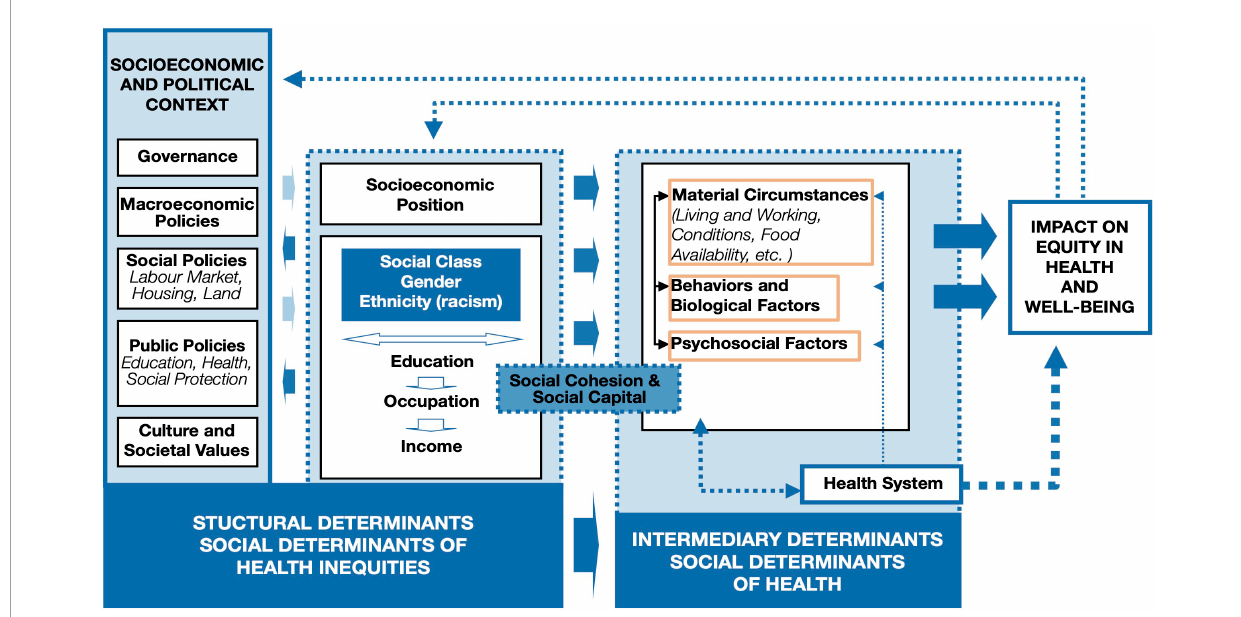
FIGURE1 The World Health Organization (WHO) social determinants of health framework structural factors, deeply rooted in imperial policies, influence individual-level factors. Neuroscience often attributes individual brain health outcomes to individual factors (highlighted in orange boxes in the modified figure to emphasize where the majority of factors examined in the human neuroscience research fall; e.g., behaviors and biological factors, psychosocial factors), yet this diagram demonstrates that individual factors are only a small piece of the story. Individual factors are shaped, in part, by the larger socioeconomic and political context; thus, these larger contextualizing structural factors are largely missing from human neuroscientific research at present. Originally published by the World Health Organization (Solar and Irwin, 2010) on page 6 in A conceptual framework for action on the social determinants of health. Permission was granted to reproduce this